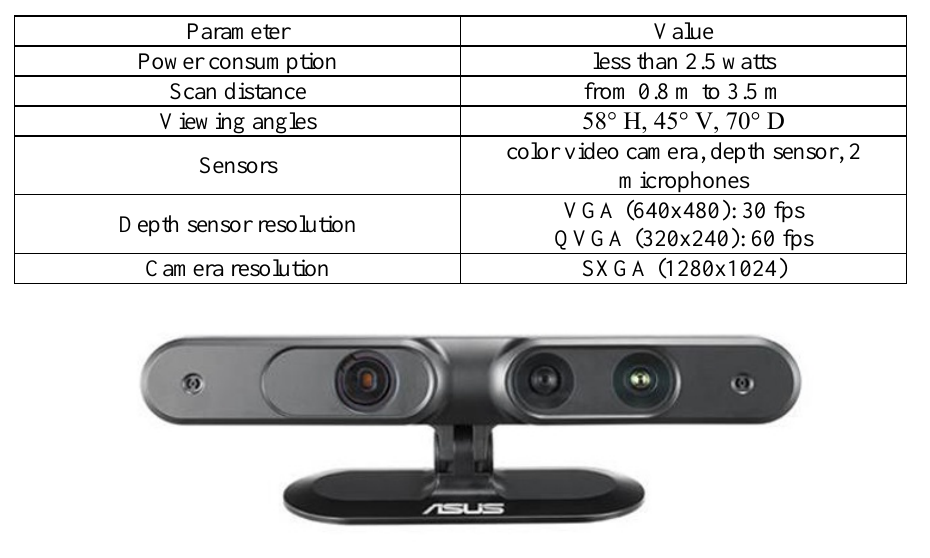
Table 2. Technical documentation for the Asus Xtion sensor.